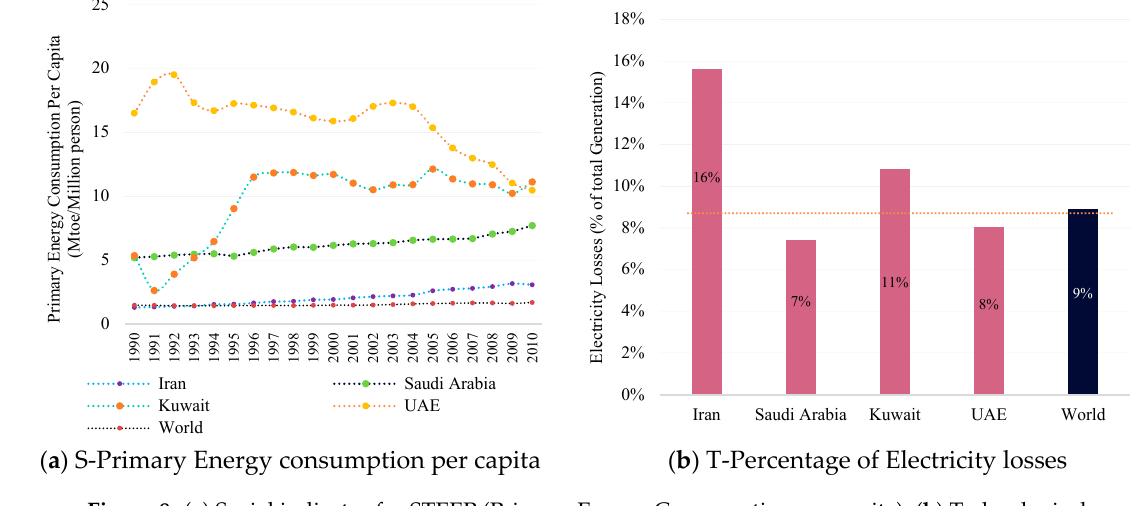
Figure 8. ( a ) Social indicator for STEEP (Primary Energy Consumption per capita); ( b ) Technological indicator (percentage of electricity and transmission losses).